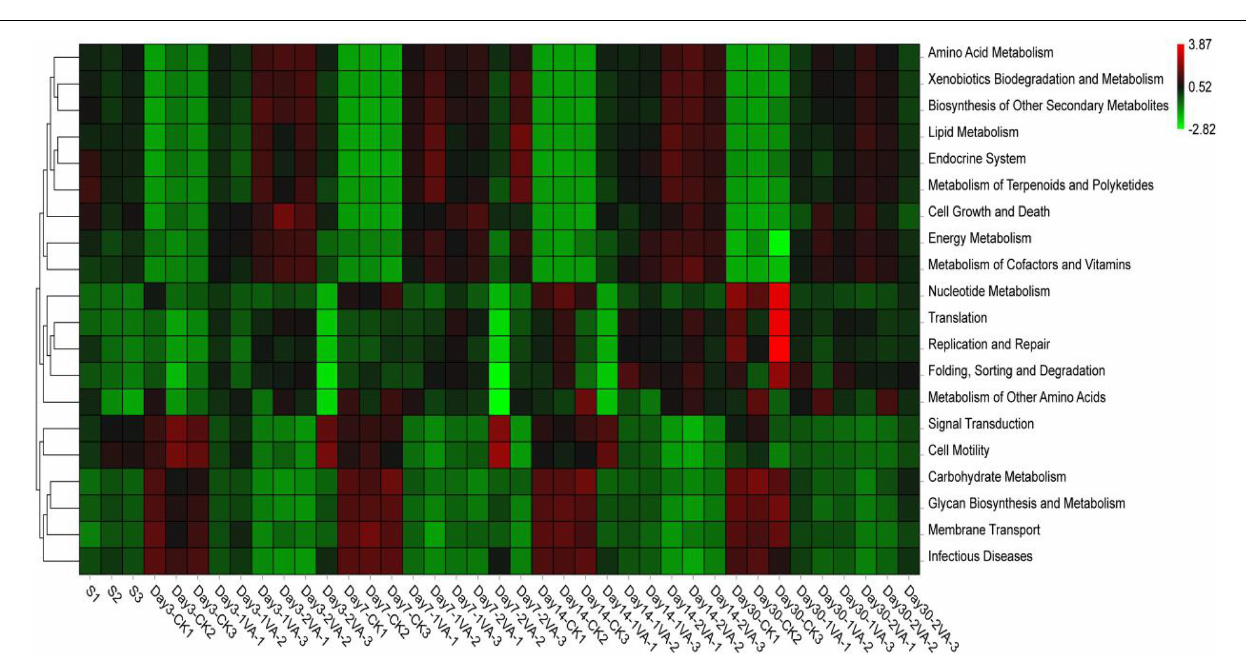
FIGURE 4 | Relative abundance of bacterial community on genus level in stylo silage ensiled with the addition of vanillic acid (S: raw material, i.e., fresh stylo, CK: blank control, 1 and 2%: addition of 1 or 2% vanillic acid).